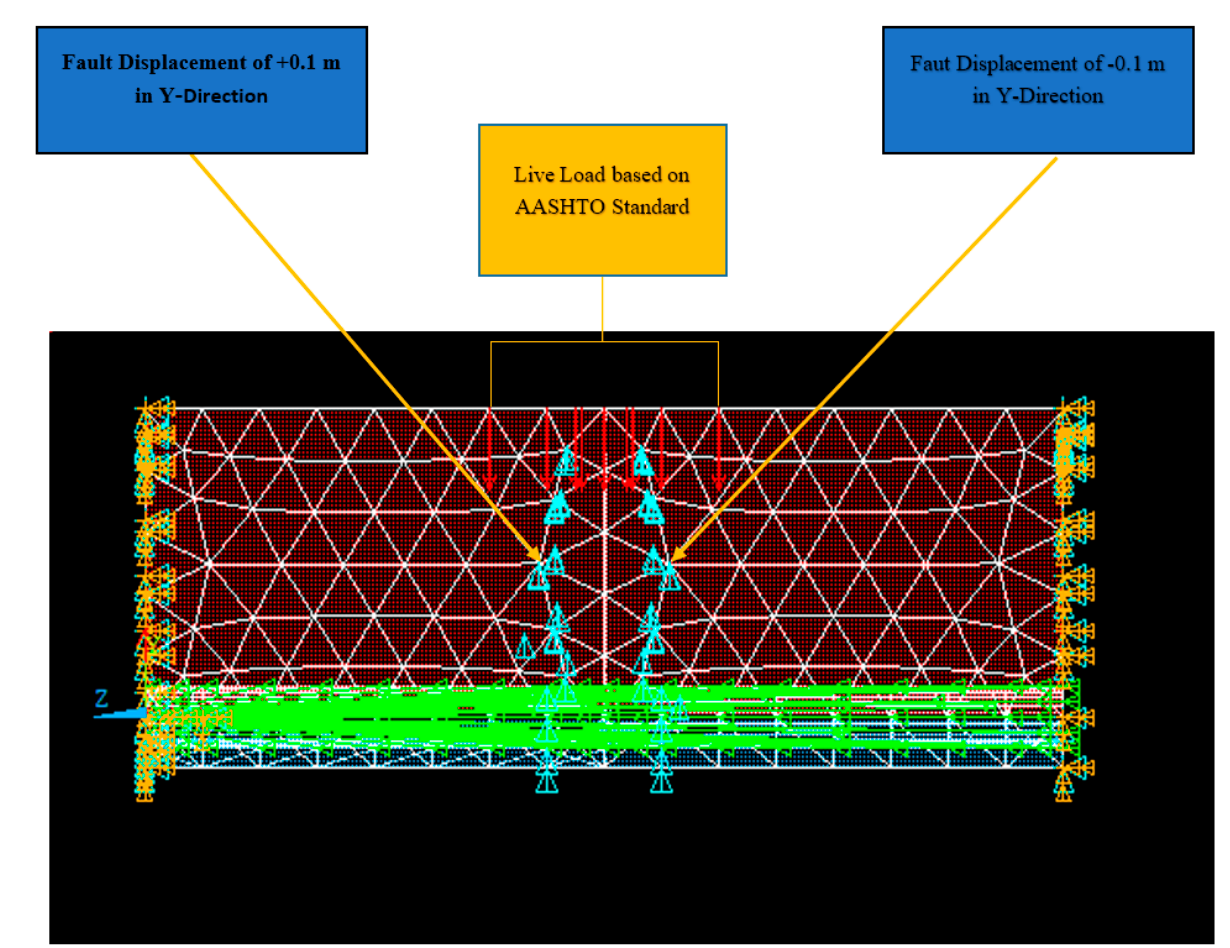
Figure 9. The static loading applied in the middle part of the GPC pipe in ANSYS.